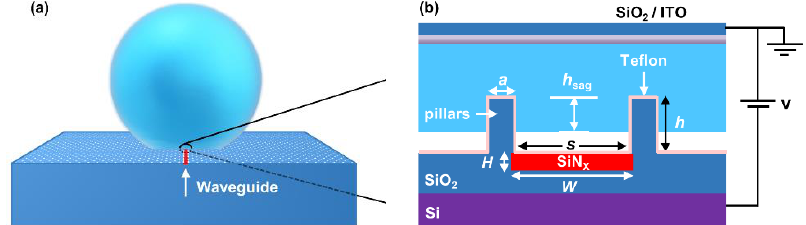
Figure 1. ( a ) The schematic of the proposed tunable Bragg grating filter; ( b ) The enlarged portion of the droplet – pillar – waveguide intersection. The parallel-plate electrowetting on dielectric (EWOD) is adopted in this optofluidic adopted in this optofluidic configuration.